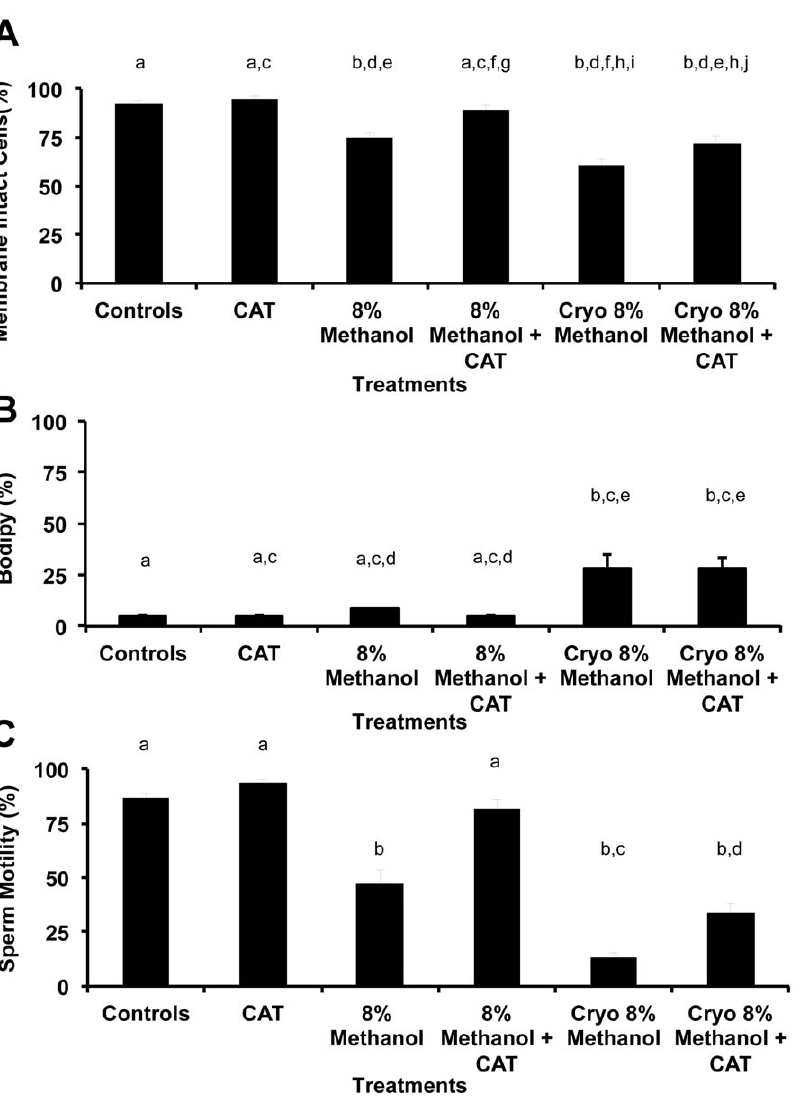
Figure 4. Evaluation of the lipid membrane ROS in zebrafish spermatozoa during cryopreservation and its effect on viability and motility demonstrated the same pattern as in Fig. 3. ( A ) Methanol (8%) decreased the viability of zebrafish sperm in fresh and cryopreserved treatments, and the addition of CAT to the methanol improved its viability in pre- and post cryopreservation treatments (P , 0.05, ANOVA, F=19.0). ( B ) Cryopreservation increased ROS 3.0-fold (P , 0.05), but CAT did not mitigate it (P . 0.5, ANOVA and Tukey’s Multiple Comparison test, F=13.4). ( C ) The addition of 8% methanol decreased zebrafish sperm motility in fresh and cryopreserved treatments (P , 0.05), and the addition of CAT to the methanol improved its viability in pre- and post cryopreservation treatments (P , 0.05, ANOVA and Tukey’s Multiple Comparison test, F=19.0). Bars with the same letter are not significantly different (P . 0.05), but bars with different letters are (P , 0.05). X- axis categories and sample sizes were: Control= live sperm stained with DHE, N=12; CAT (200 U/ml, concentration used in all CAT treatments), N=5; 8% Methanol, N=12; 8% Methanol + CAT 200, N=12; Cryo 8% Methanol = sperm cryopreserved according to [6] with 8% methanol, N=12; Cryo 8% Methanol + CAT, N=12.